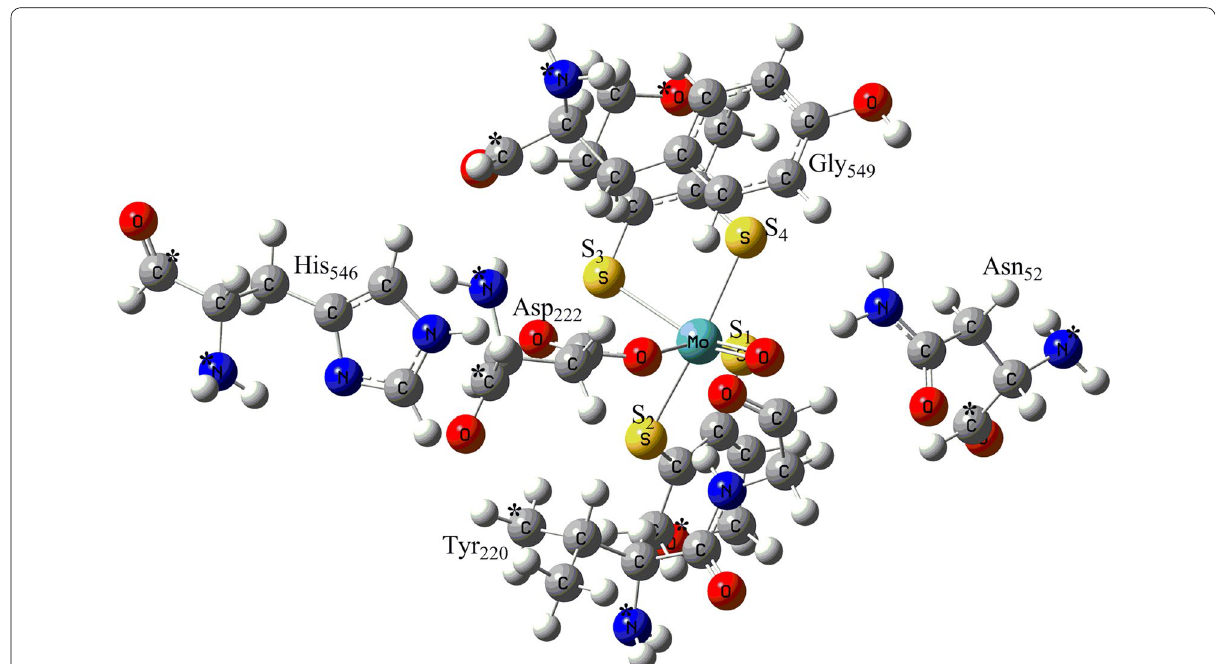
Fig. 3 Optimized oxidized active site model of Mo-Nar. Atoms labeled (*) were kept fixed at their X-ray crystal structure